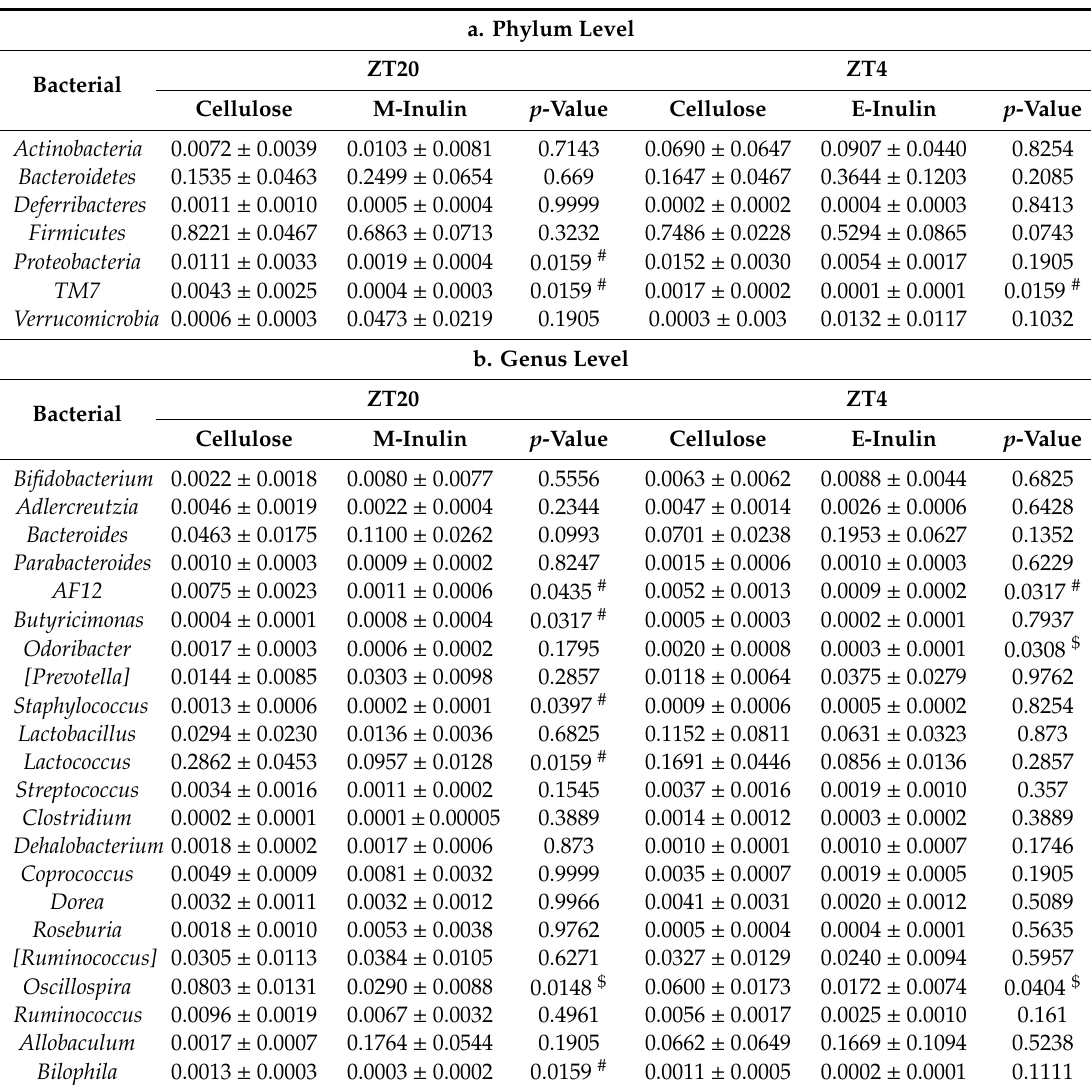
Table 1. The relative abundance of some bacteria under the condition of two meals per day. ( a ). Phylum level. ( b ). Genus